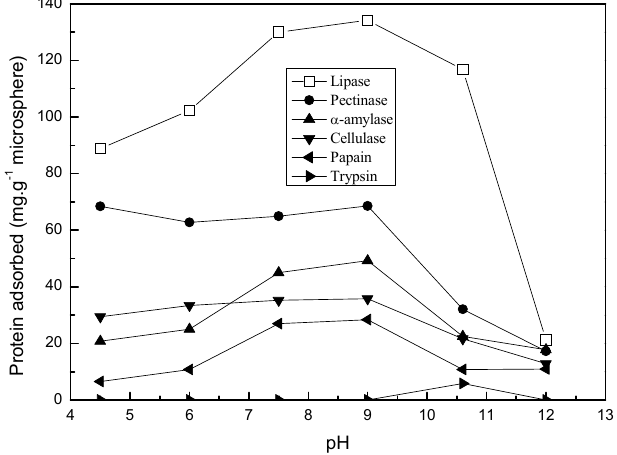
Figure 7. The protein adsorption of the polyamine microsphere at various pH and at 25